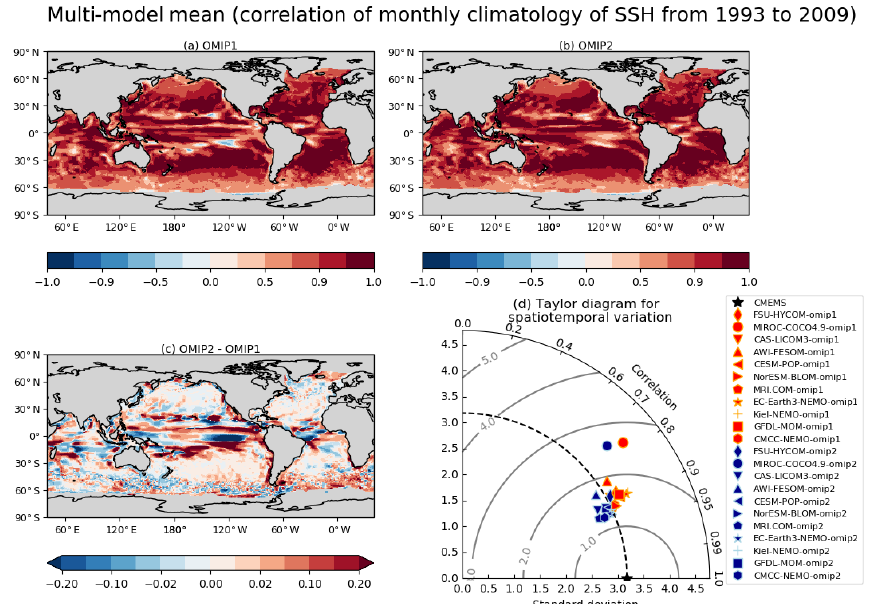
Figure E3. Multi-model mean correlation coefficients of monthly climatology of SSH for the period 1993–2009 between simulation and CMEMS. (a) OMIP-1, (b) OMIP-2, (c) OMIP-2 − OMIP-1. (d) Taylor diagram of the total space–time pattern variability of the monthly climatology of SSH of OMIP-1 and OMIP-2 simulations relative to CMEMS, with standard deviations expressed in units of centimeters. See Figs. S55–S57 for results of individual models.